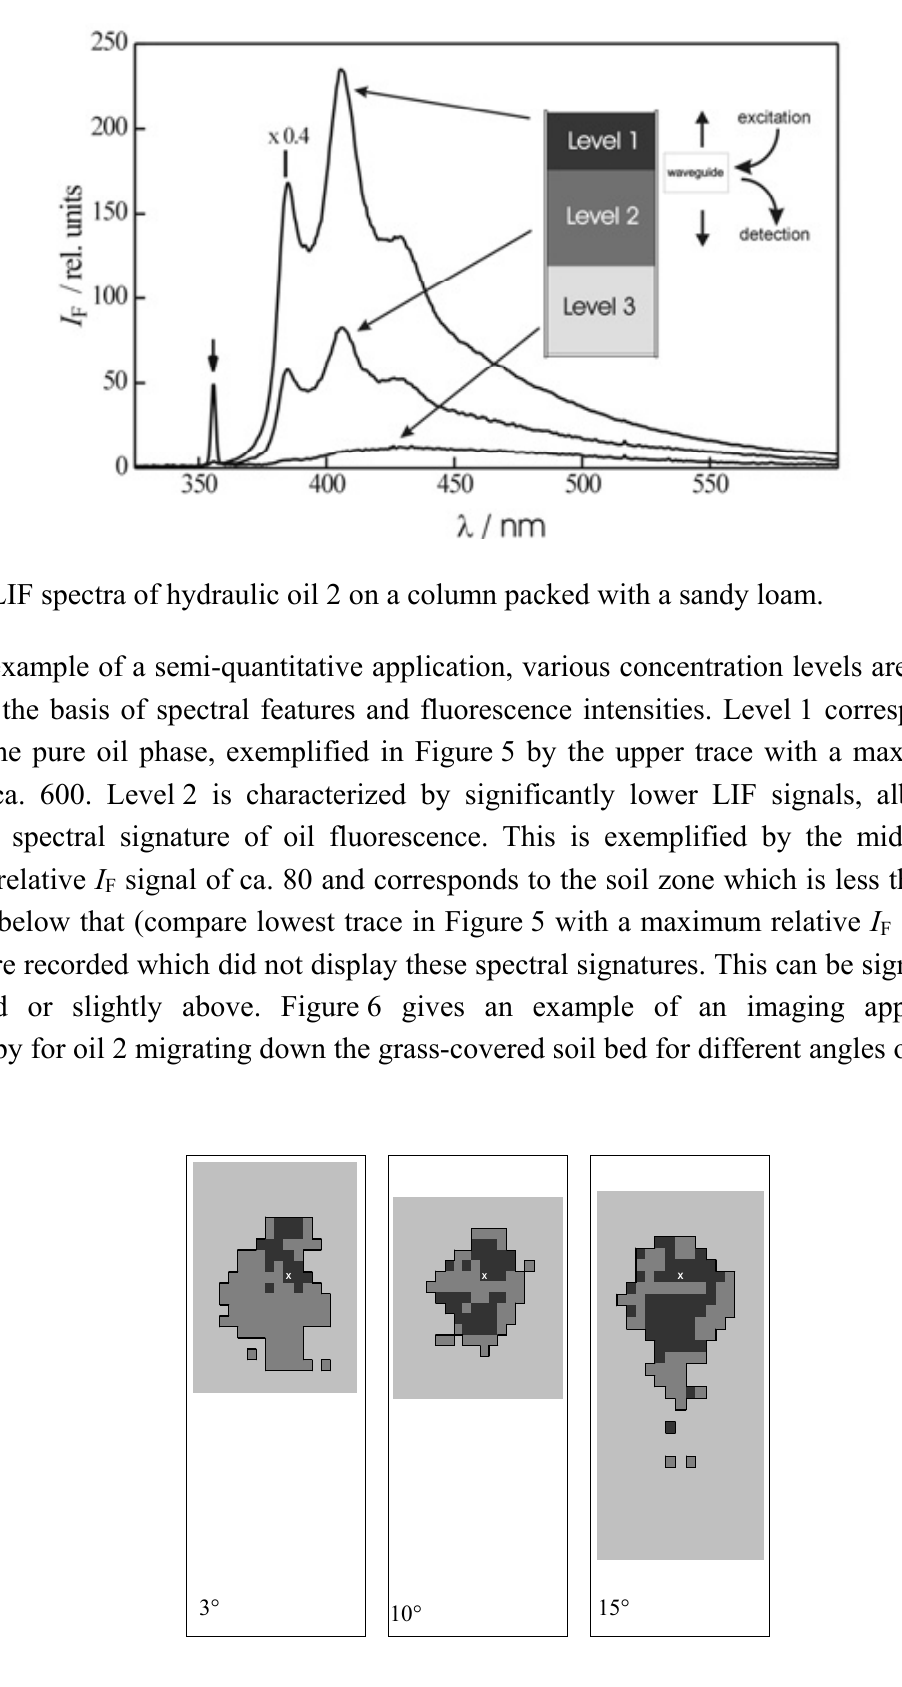
Figure 6. LIF spectroscopy for in situ profiling of spreading hydraulic oil 2 on a grass covered soil surface. The “X” denotes the point were the oil was